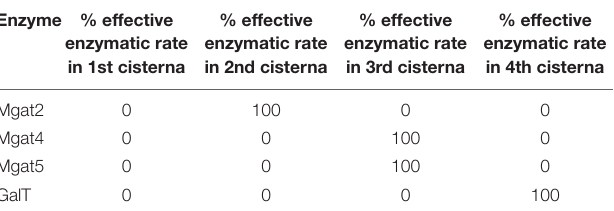
TABLE 2 | Distribution of Mgat2, Mgat4, Mgat5, and GalT in an engineered Golgi apparatus to maximize tetra-antennary glycans. Enzyme % effective enzymatic